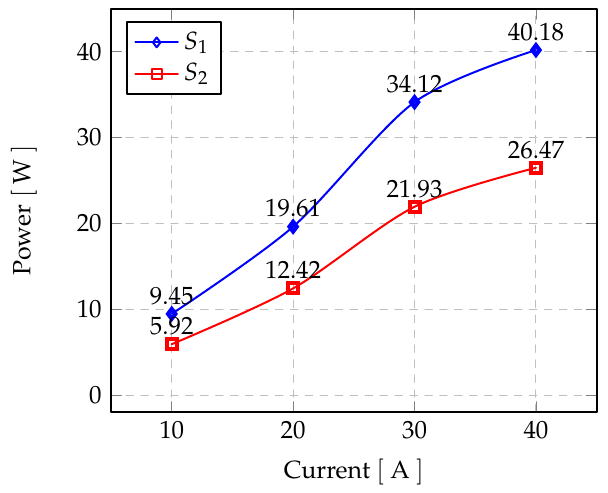
Figure 6. Total power losses of S 1 and S 2